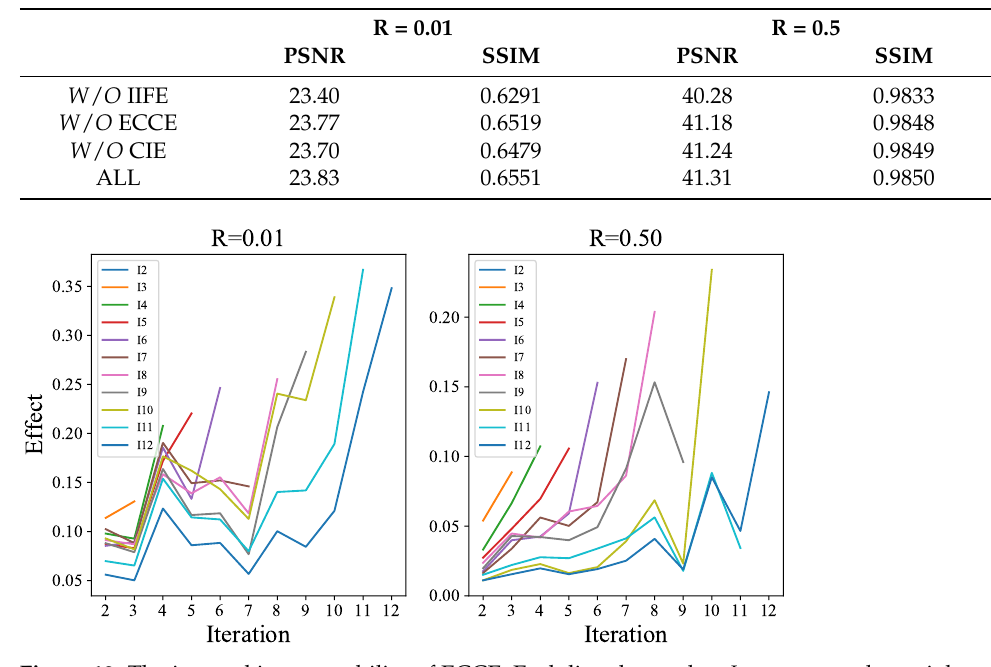
Figure 10. The internal interpretability of ECCE. Each line denoted as I i represents the weights of the convolution layer from ECCE i in iteration i . On a specific polyline I i , there are different weight responses for different input channels. Based on these weights, the importance of each channel in the whole task can be measured because the larger the weight is, the higher the proportion of information extracted from the corresponding input channel. Point ( x , y ) indicates how valuable the specific input channel ( EEI x , x ∈ [ 2, i − 1 ] or CFEI i , x = i ) is in the calculation of ECCE i